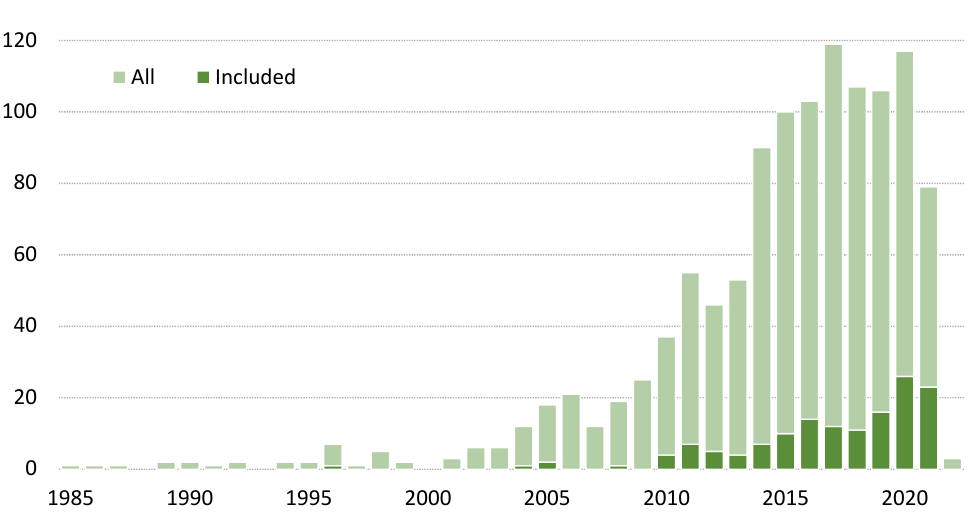
Figure 3. The frequency of articles by year of publication. All unique papers found ( N = 1167) are shown in light green, papers included in the review are shown in dark green ( N = 144).